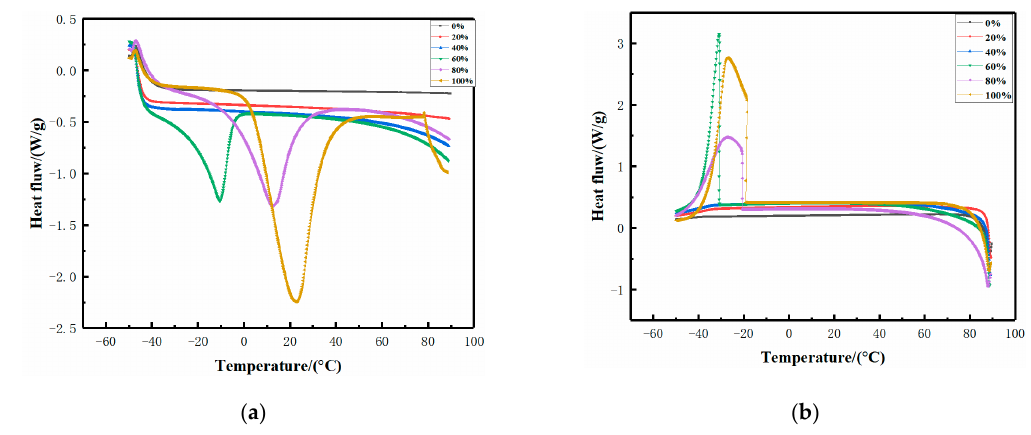
Figure 6. DSC heating curves for xanthan gum-based eutectogels with di ff erent water contents and hydrogel ( a ); DSC cooling curves for xanthan gum-based eutectogels with di ff erent water contents and hydrogel ( b ).